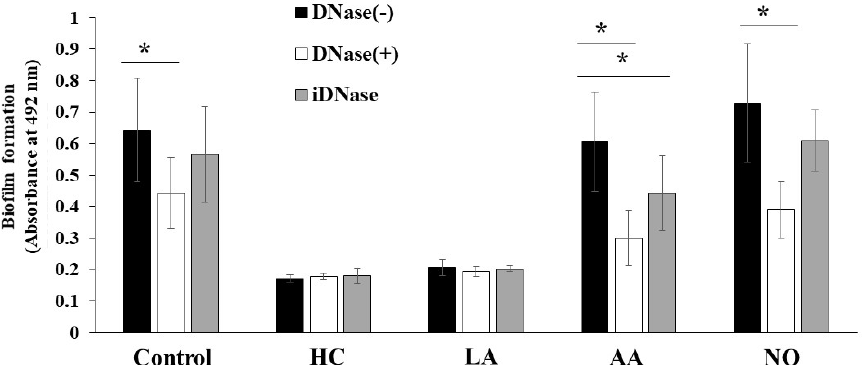
Figure 9. Role of eDNA for effects of initial pH condition on the MVs-dependent biofilm formation. Biofilm formation of S. mutans UA159 gtfBC - was quantitatively assessed in TSB with 0.25% raffinose with 0.125 mg/ ml of MVs from S. mutans UA159 in HC, LA, AA and NO, with or without DNase I and iDNase I. The data indicate the mean ± SD of three independent experiments. The asterisks indicate a significant difference between the groups (*: p < 0.05, MVs in condition without DNase-I vs MVs in condition with DNase-I or iDNase-I).